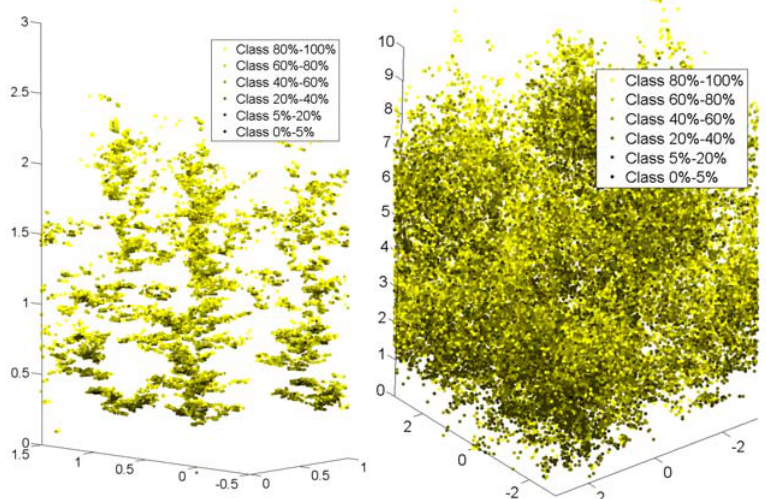
Figure 4. The two figures present the side view for the stands of LAI of 1.29, and 2.76 left and right respectively. The leaves are separated in percentage classes of absorbed light ranging from yellow (80%–100% absorbed light) to black (0%–5% absorbed light). Sun is at 10° from nadir. The axes of the figures indicate the stand dimensions in